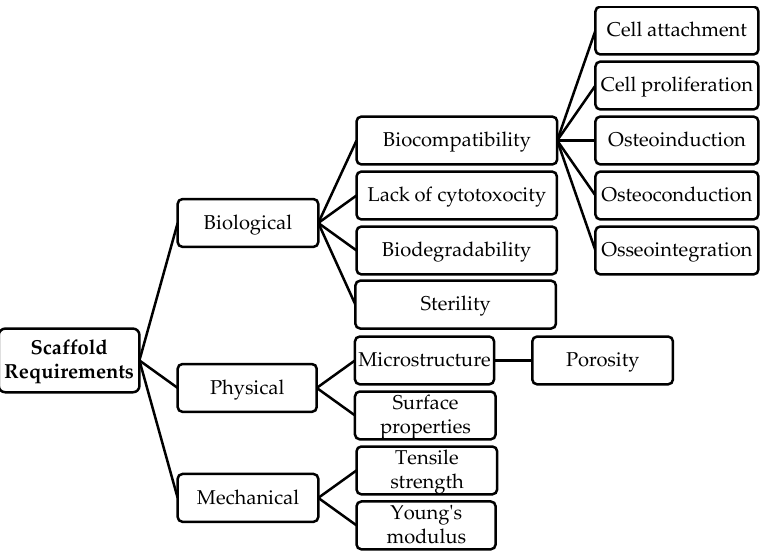
Figure 2. Scaffold requirements, from references [32 – 34].